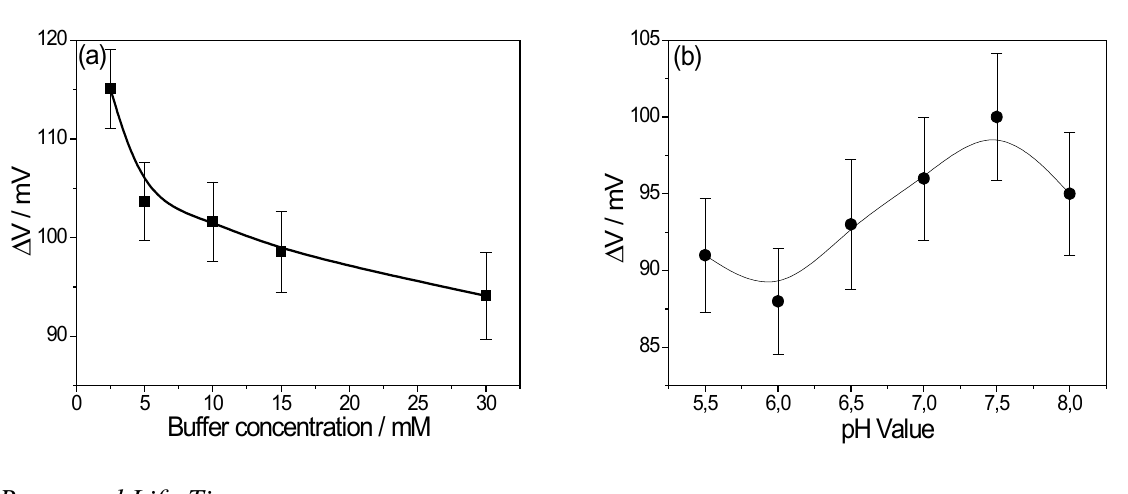
Figure 4. Influence of the buffer concentration (a) and effect of pH value on the PPI/NiTsPc-GOx FET-based glucose biosensor response (b)